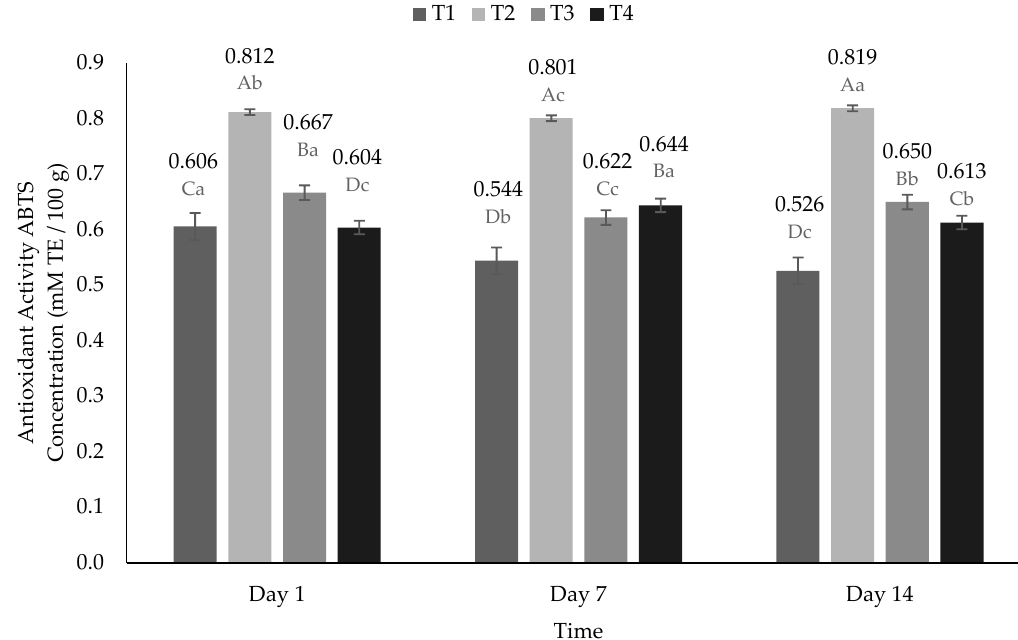
Figure 3. Antioxidant activity (ABTS˙ method) of yogurt added with beet extract. T1 = Natural yogurt (Y), T2 = Y added with beet juice, T3 = Y added with extract encapsulated with Maltodextrin, and T4 = Y added with extract encapsulated with Inulin. A,B,C,D Values with different superscript indicate significant statistical difference between treatments ( p < 0.05). a,b,c Values with a different superscript indicate significant statistical difference over time ( p < 0.05).